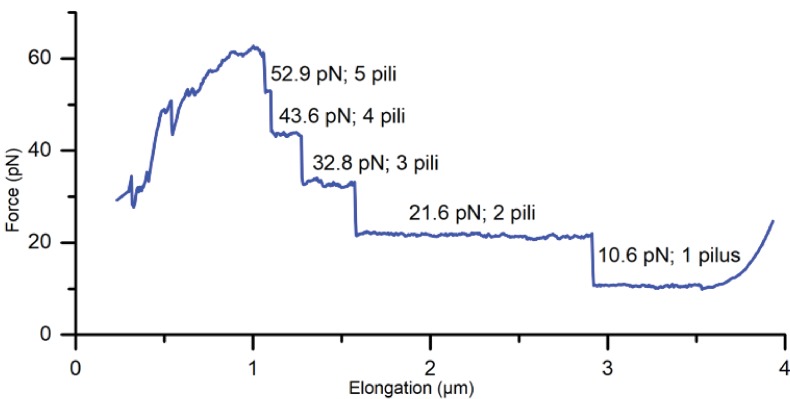
Force spectroscopy measurement showing attachment of multiple pili (A22R).Since the uncoiling force of a pilus being extended by a attached microsphere is constant, the measured force response of all attached pili is a multiple of the force required to uncoil a single pilus, thus providing discrete values for each force plateau.